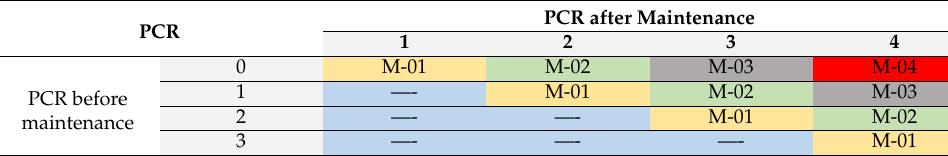
Table 2. Influence of repair decisions on PCR